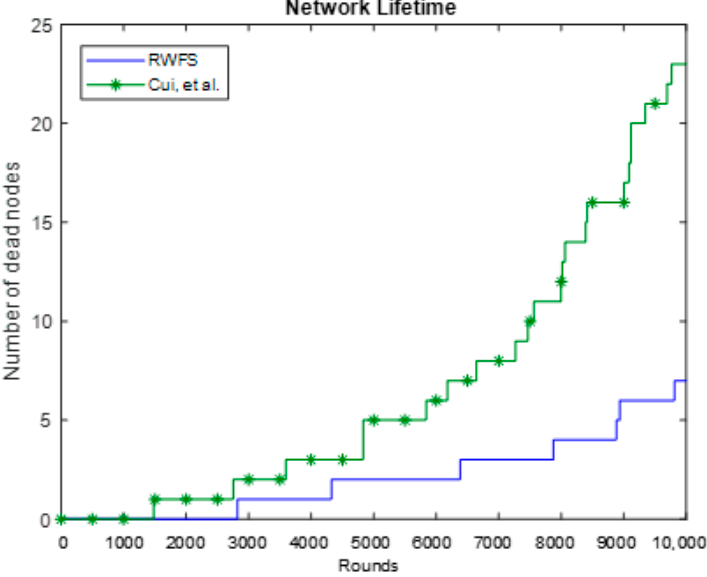
Figure 9. The network lifetime analysis between RWFS (the proposed scheme) and the Cui et al. scheme. The number of dead nodes is calculated at each round in a duration of 10,000 rounds.